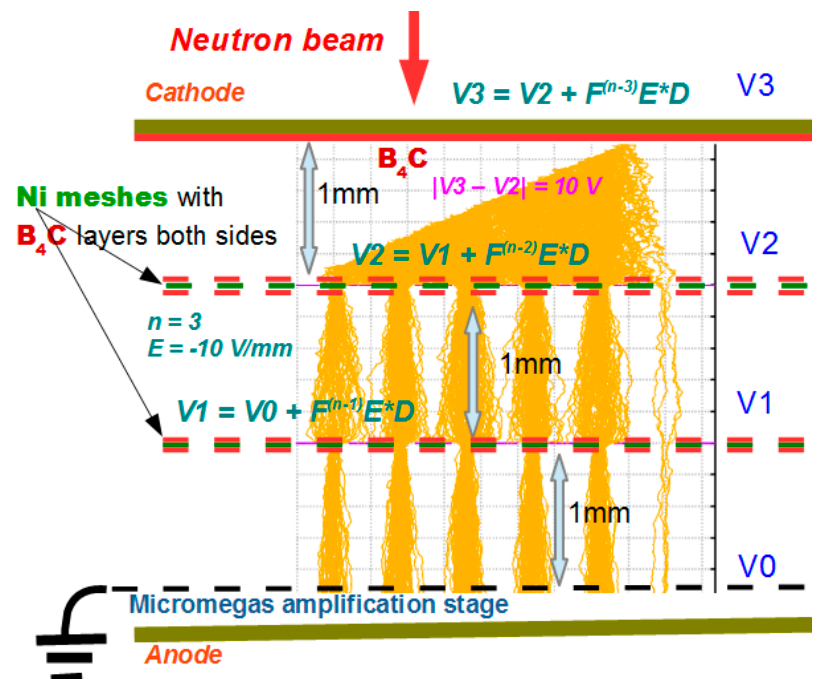
Figure 1. A single two-mesh detector unit with five layers of 10 B 4 C (two two-side-coated woven nickel meshes and one one-side coated aluminum) and the electron transmission in a gas mixture of CF 4 obtained with Garfield simulations [11].